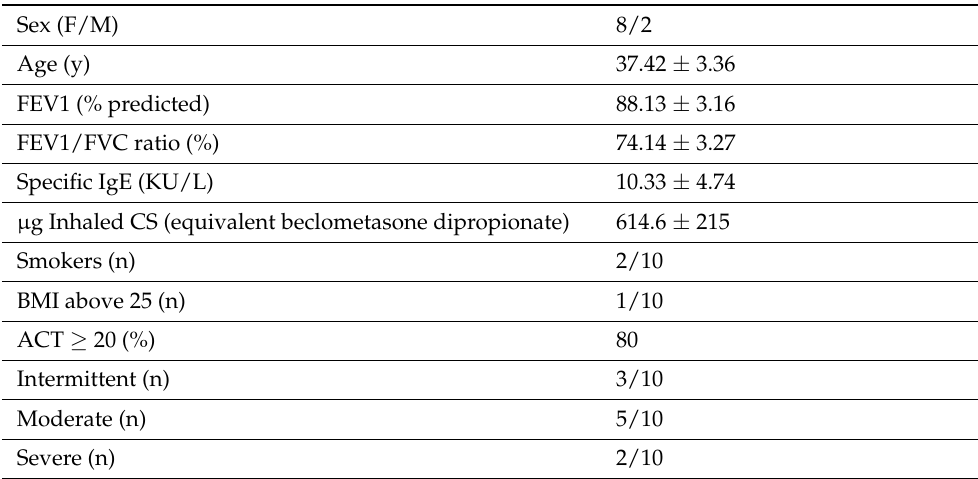
Table 2. Asthma patients’